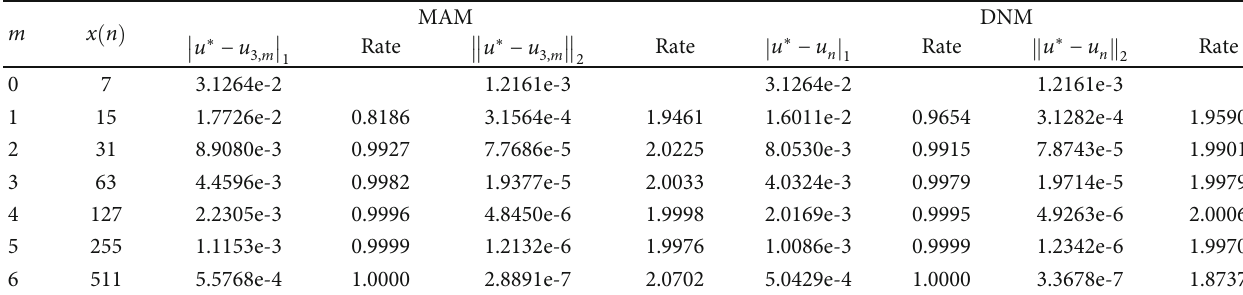
Table 2: Errors and convergent orders of MAM and DNM via linear basis in spatial direction with k = 3, τ = 0 : 001 , and α = 0 : 25 for Example